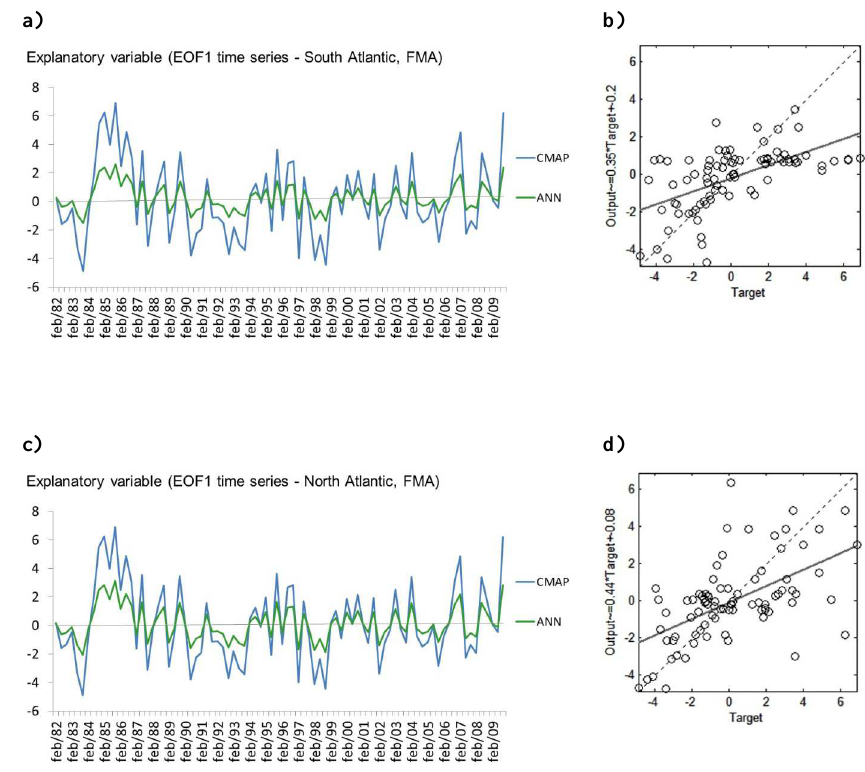
Fig. 9. As in Fig. 8 but for FMA season. The R-values are 0.57 and 0.56 for panels (b) and (d) ,